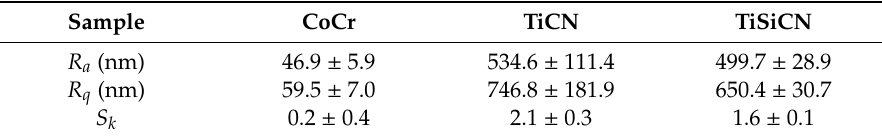
Table 3. Main roughness parameters of the investigated